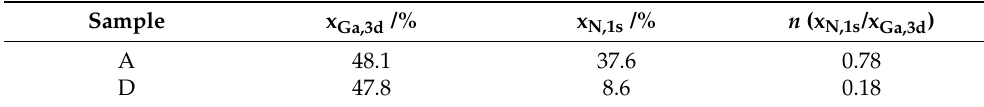
Table 2. Treatment conditions of all